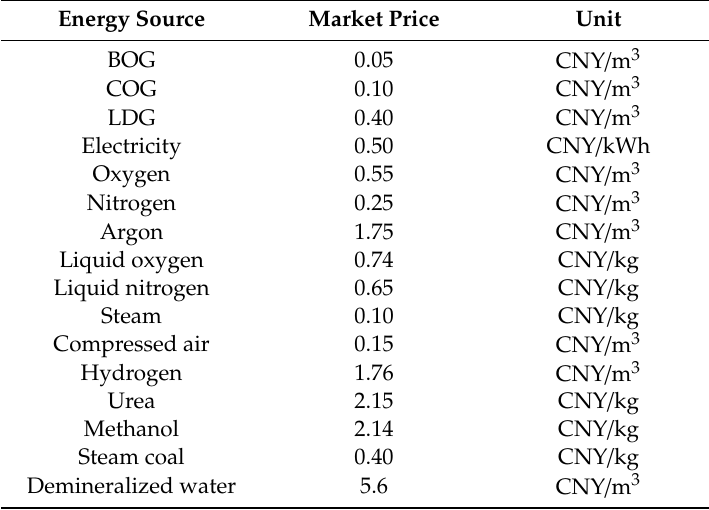
Table 1. Market prices of the energy source.